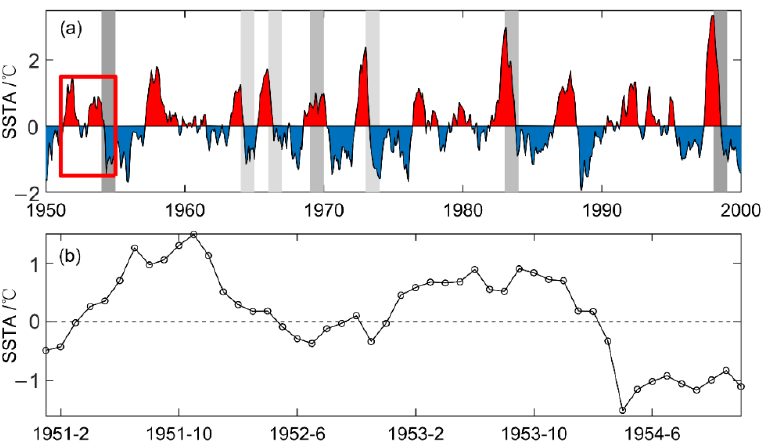
Figure 3. Sea surface temperature anomalies (SSTAs) in the NINO3 region: ( a ) SSTAs from 1950 to 2000, the shadows indicate the flood disasters that may relate to the ENSO events, grayscale represents the disaster degree; ( b ) SSTAs between 1951 and 1954.